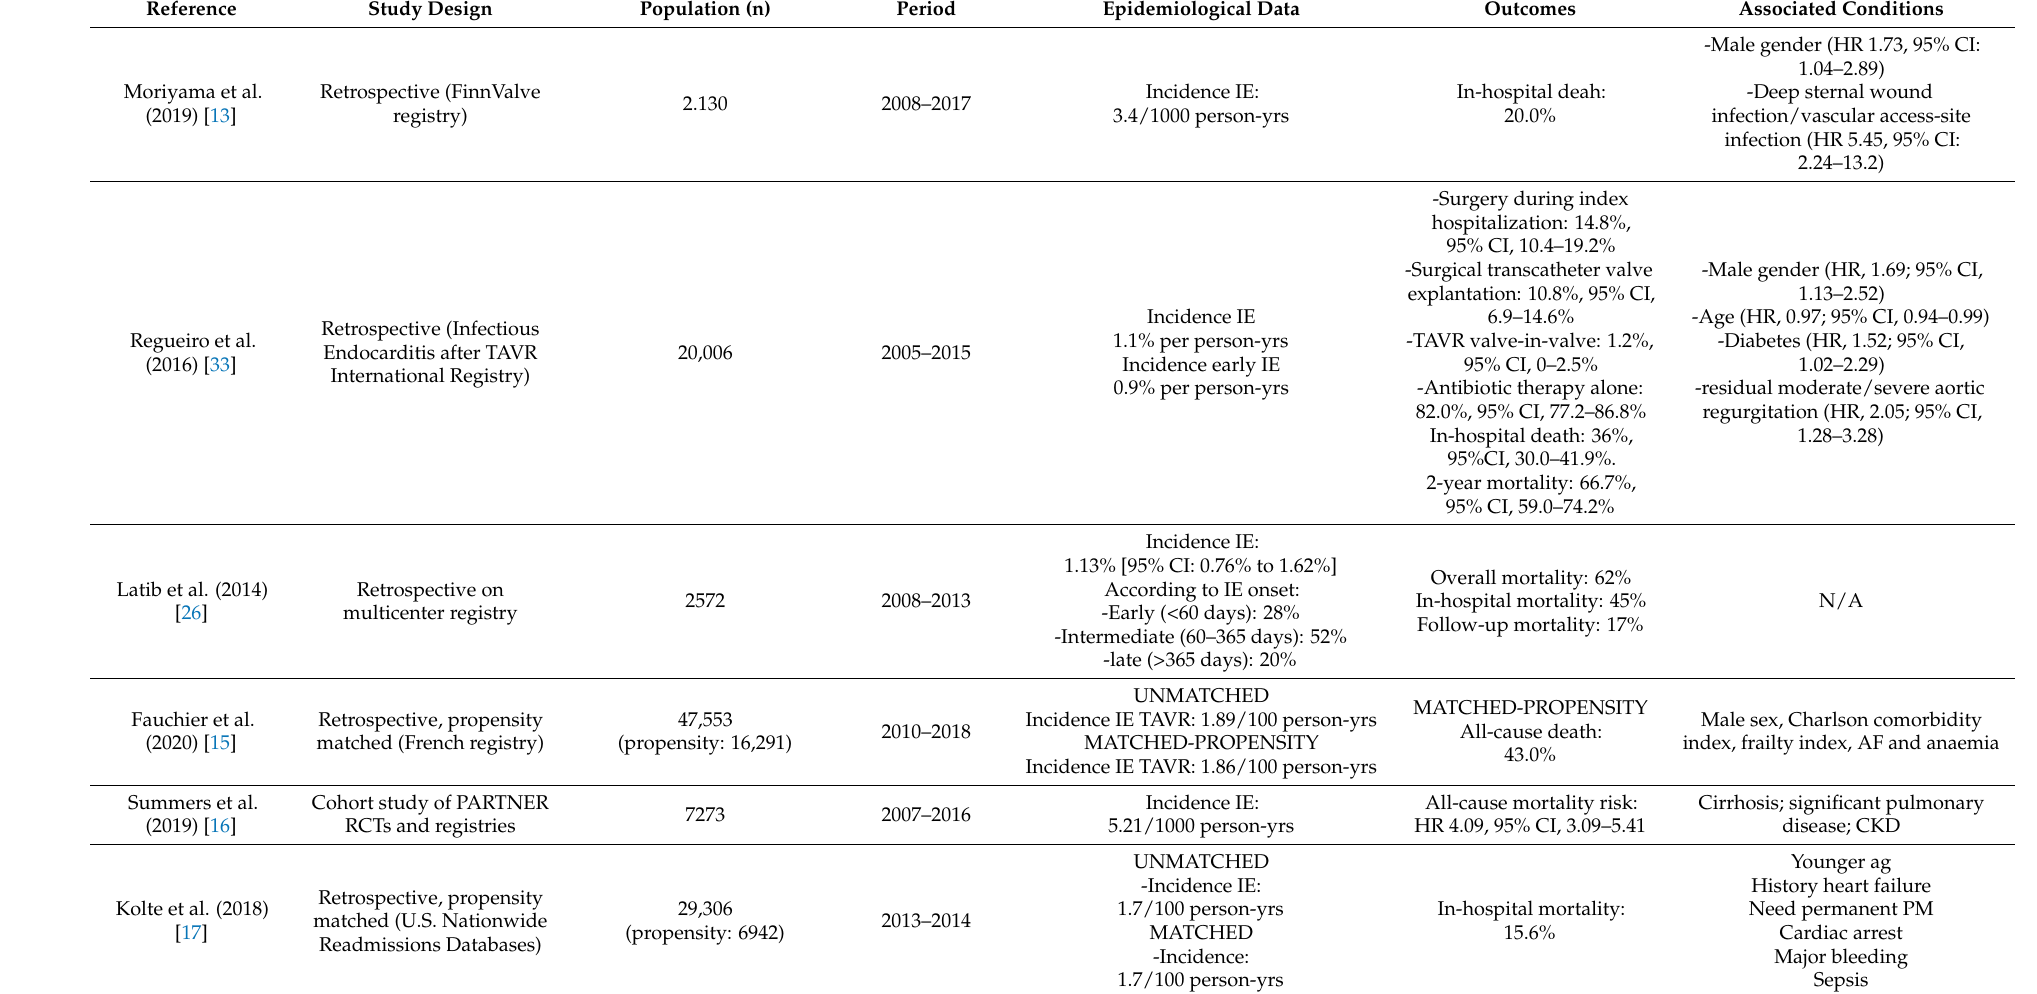
Table 3. Characteristics of the main studies dealing with infective endocarditis in transcatheter aortic valve replacement